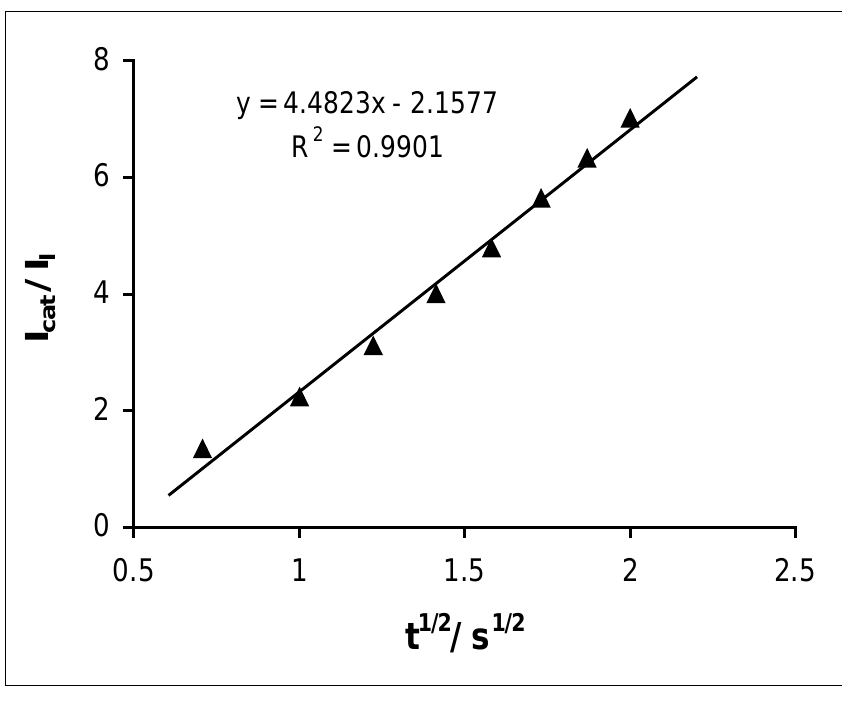
/I vs t 1/2 cat L